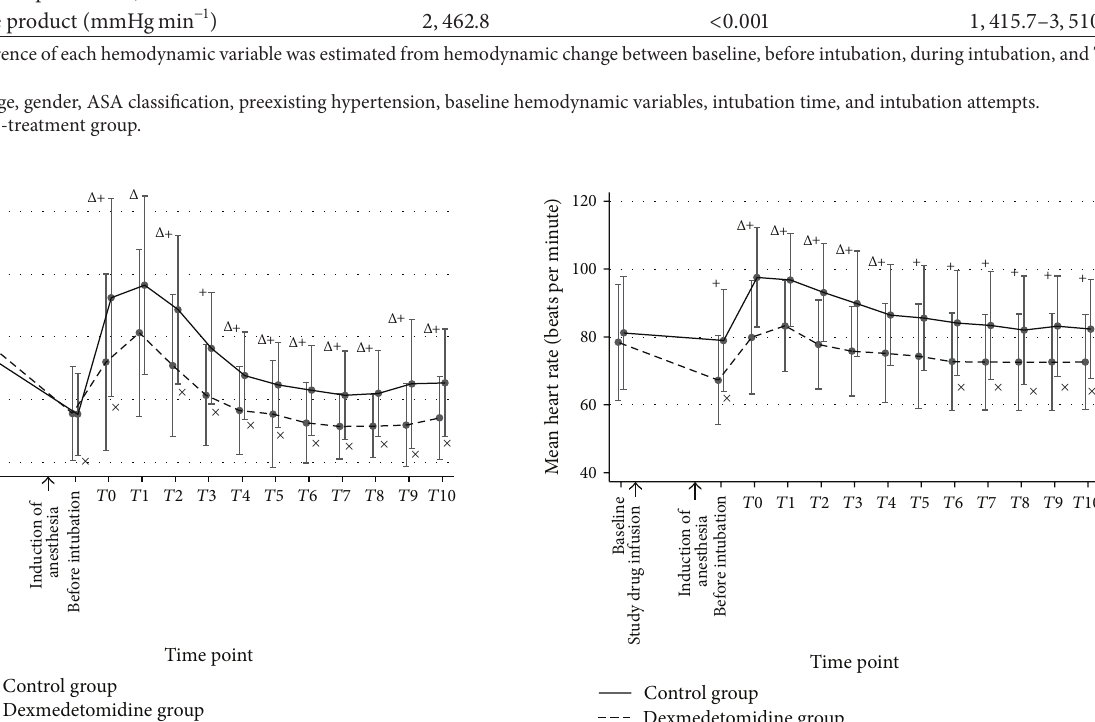
Figure 5: A line graph demonstrated the mean HR and their stan- dard deviation comparing groups at different time points. Baseline refers to the point of time before the study drug is administered. Before intubation refers the point of time after anesthetic induction just before DLT intubation. T0 is the period during intubation. T1– T10 refer the points of time as minutes after intubation. HR: heart rate. + P value < 0.05 compared between groups. Δ P value < 0.05, significant difference compared with baseline in the control group. × P value < 0.05, significant difference compared with baseline in the dexmedetomidine